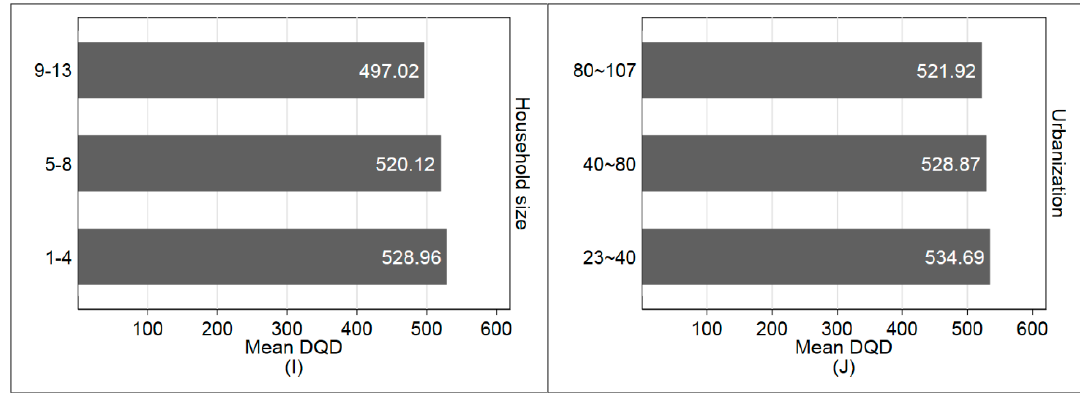
Figure 3. DQD for different subpopulations. ( A ) Across different quartile income groups; ( B ) across different labor intensity levels; ( C ) education: 1 = 0–6 years; 2 = 7–9 years; 3 = 10–12 years; 4 = more